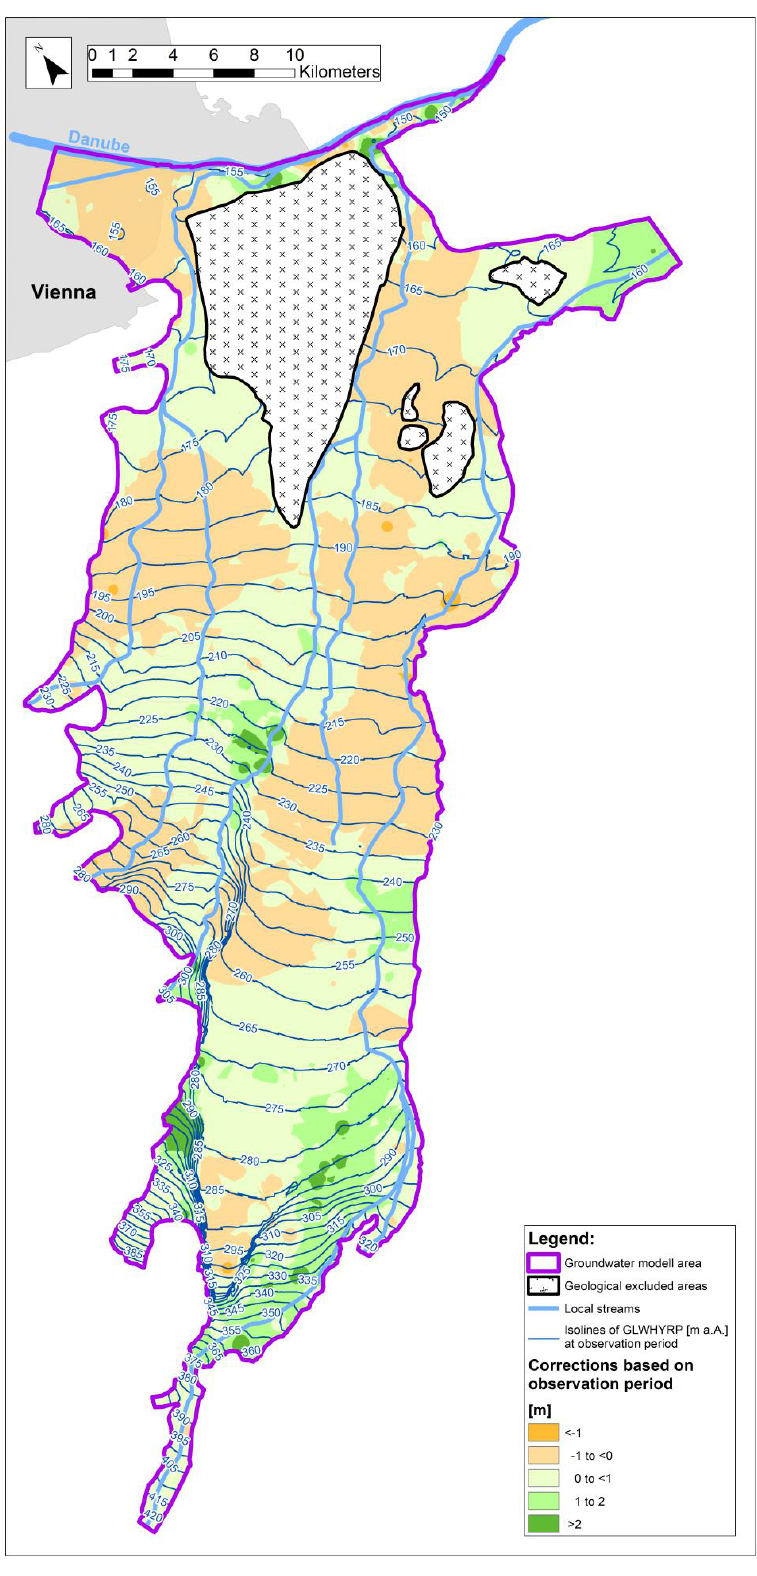
3 Figure 5. Distribution of GLsWHYRP based on modelled groundwater levels corrected by interpolated discrepancies during observation period at observation wells; colored areas show resulting